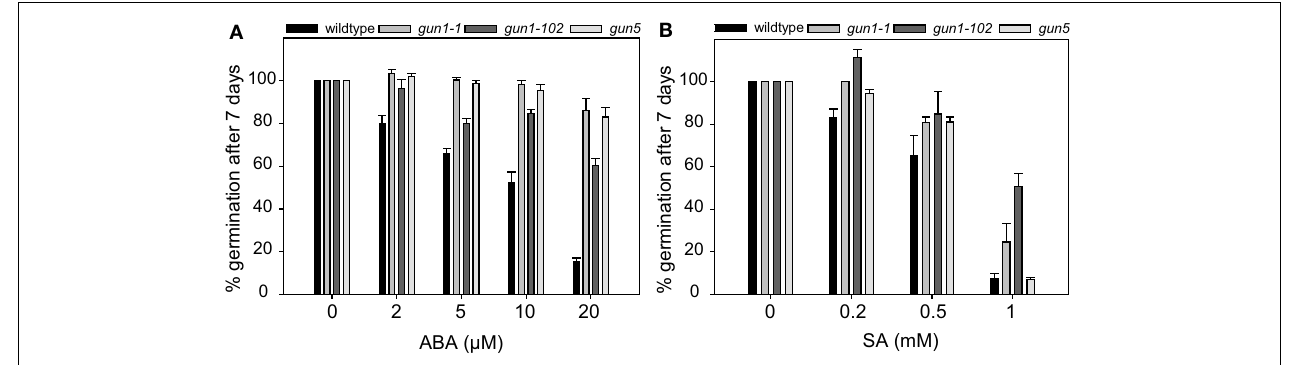
growth at 21˚C in a 16-h light/dark regime.Values are the means ± SEM obtained from at least three independent experiments with 20–50 seeds each.The average percentage of germination of seeds in the control experiments without ABA or SA, respectively, was set to 100% and used as a reference to calculate the percentage of germination in the germination assays done in the presence of ABA or SA.